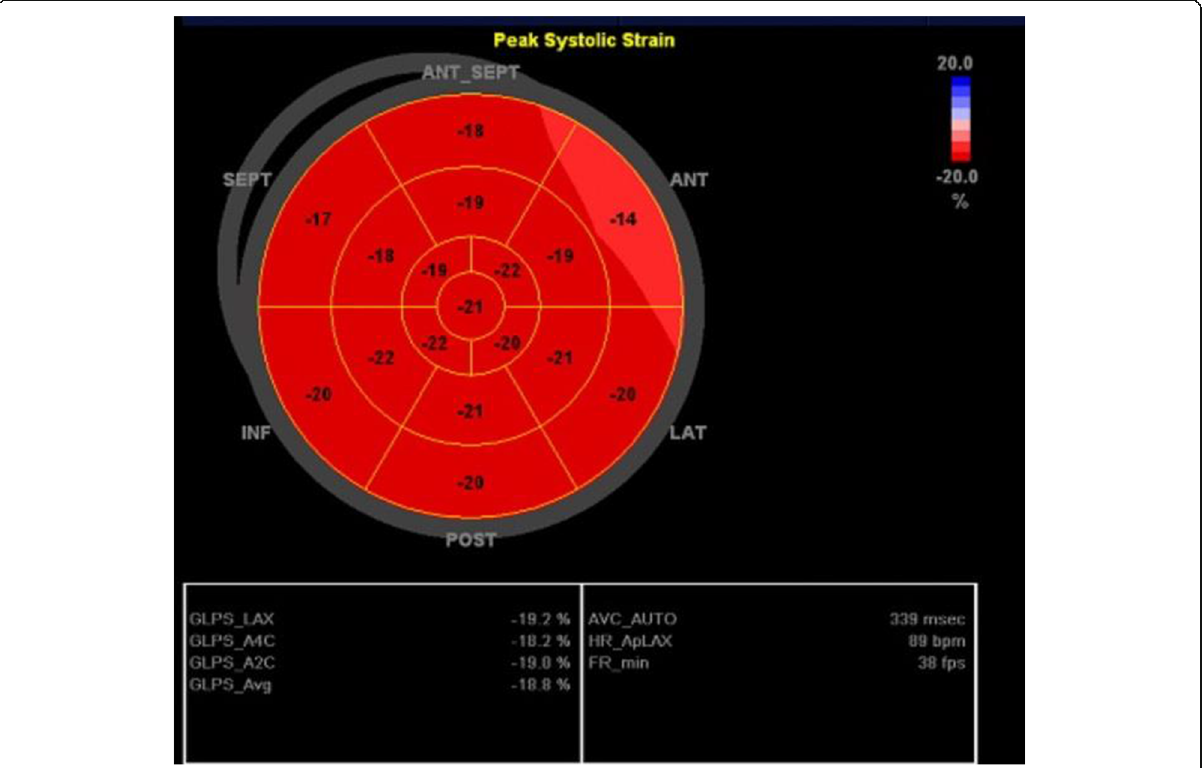
Fig. 4 Bull ’ s eye map of each segment with global longitudinal strain (GLS) of 2, 3, and 4 chamber views and average GLS